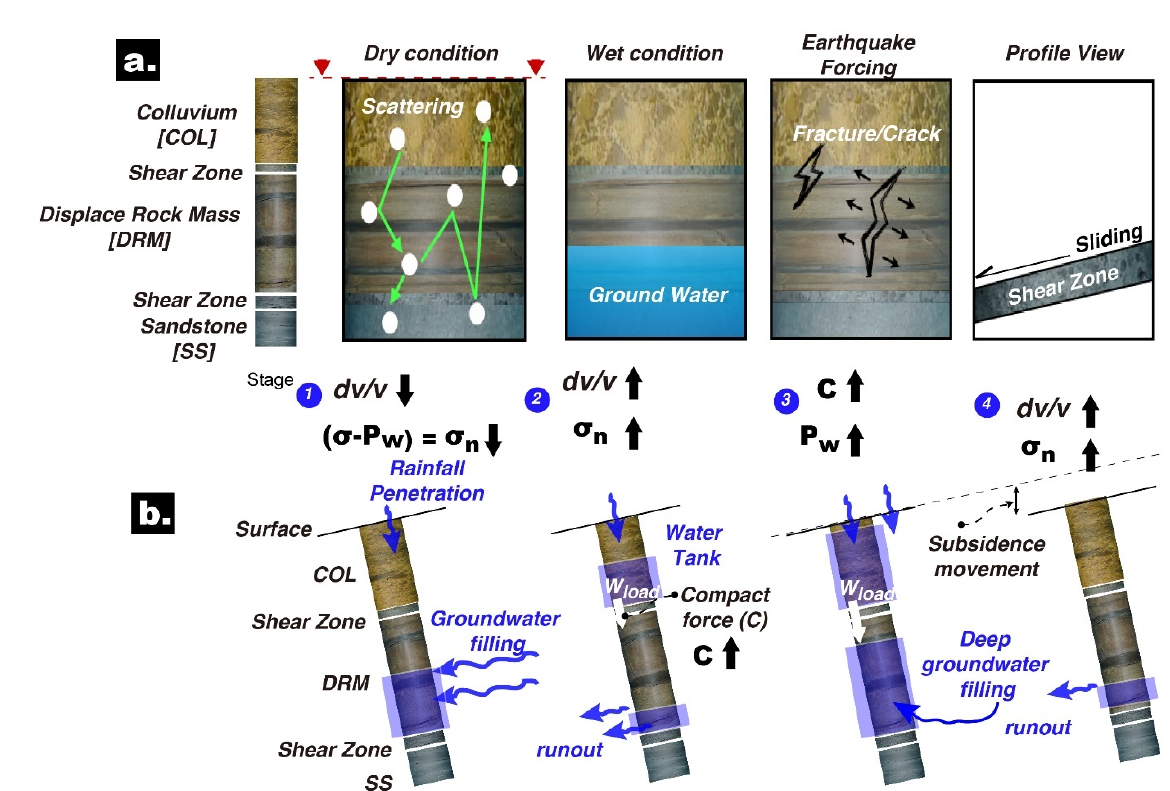
Figure 5. Source mechanisms contributing to variation in dv / v and the hypothetical model: ( a ) Concept of the coda wave scattering model for the relative seismic velocity changes ( dv / v ) caused by groundwater level, earthquakes, and material changes in sliding depth. The red triangles indicate the seismometer deployed outside the landslide area; ( b ) Four stages explain the different patterns of seismic velocity changes ( dv/v ). The effective normal stress ( σ n ) acting on the main sliding surface is equal to the normal stress ( σ ) minus the water pore pressure (P w ). C indicates the compact force induced by water tank.